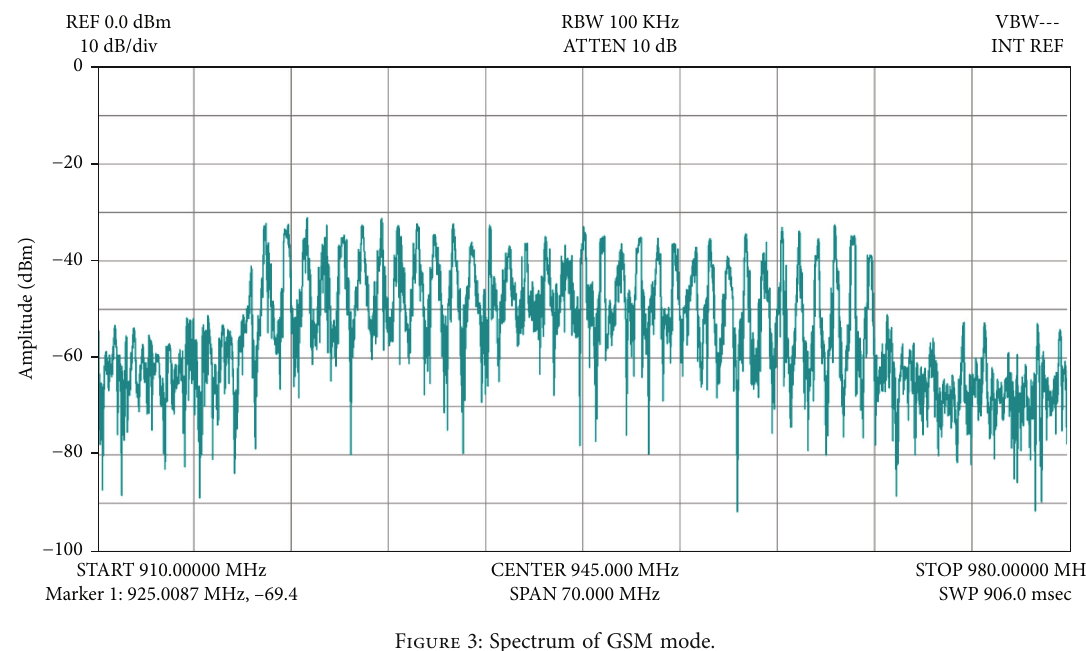
Figure 3: Spectrum of GSM mode.